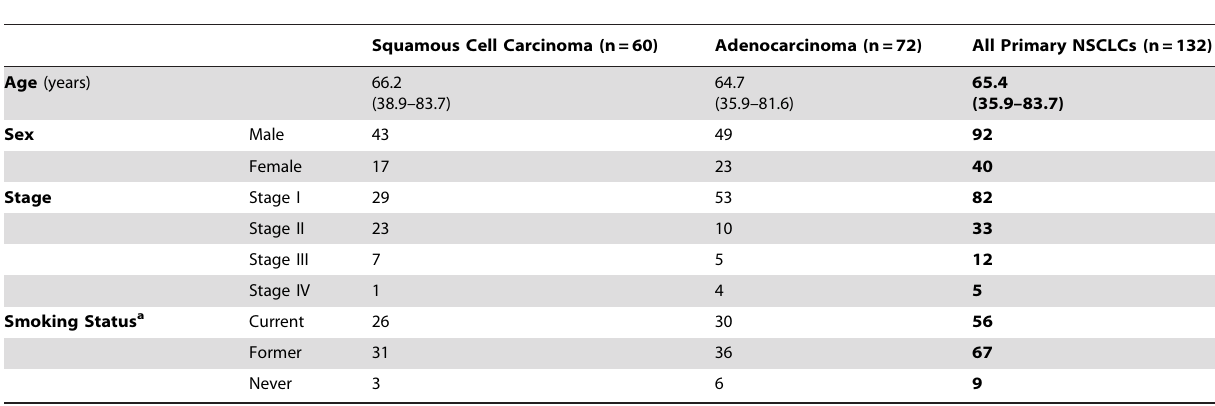
Table 1. Clinicopathological characteristics of arrayCGH